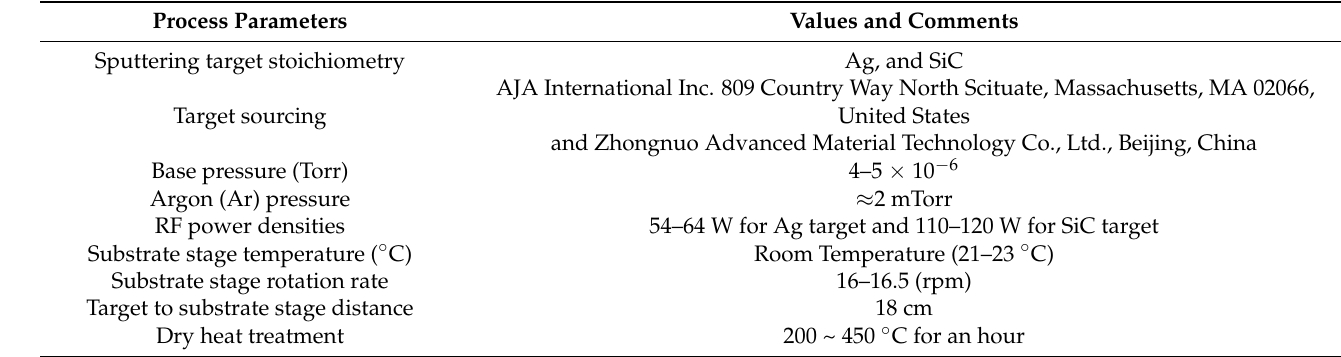
Table 1. Summary of the process parameters and conditions used to prepare composite layers on glass